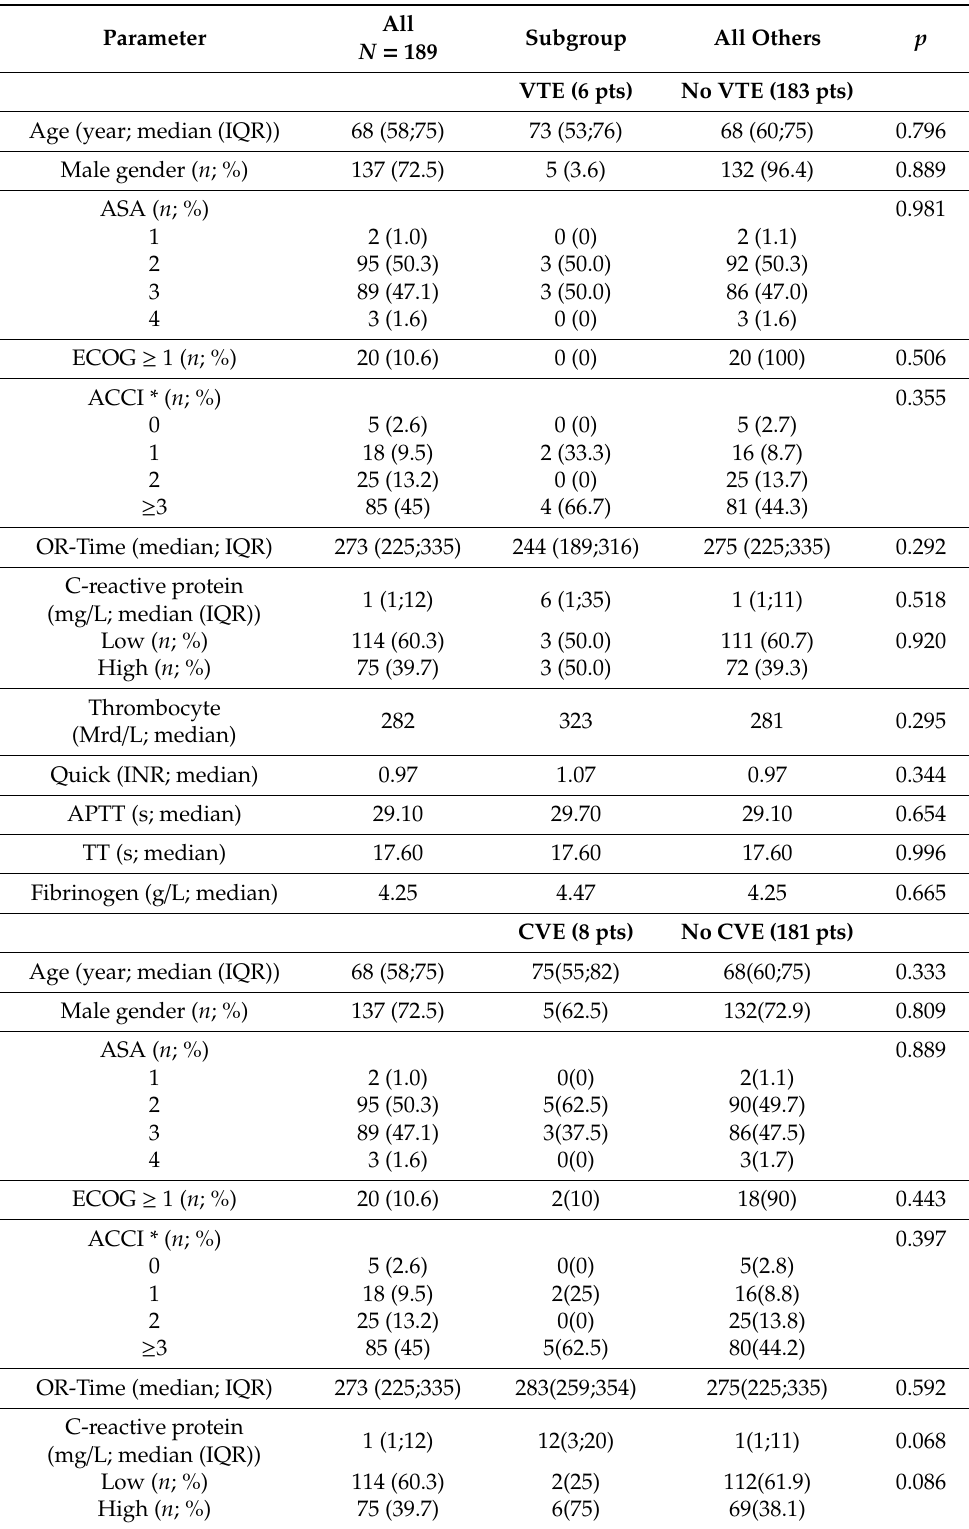
Table 3. Analyses of clinical and laboratory index parameter in patients with venous thromboembolic or cardiovascular events after radical cystectomy for UCB